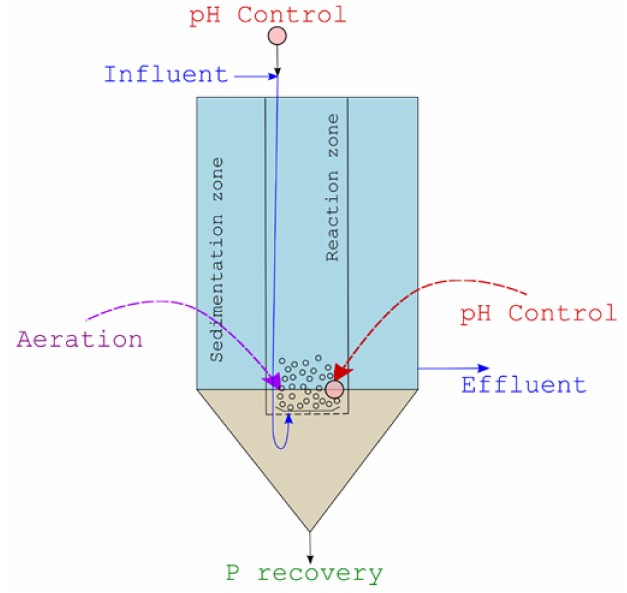
Figure 1. Scheme of the experimental